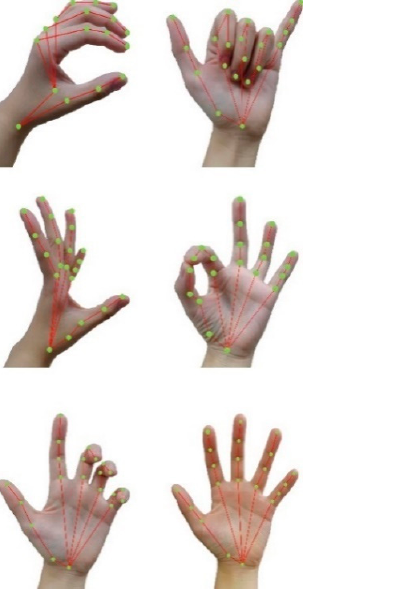
Figure 3. Multi ‐ segments model for human body: ( a ) hand skeletal model, ( b ) whole body skeletal model.